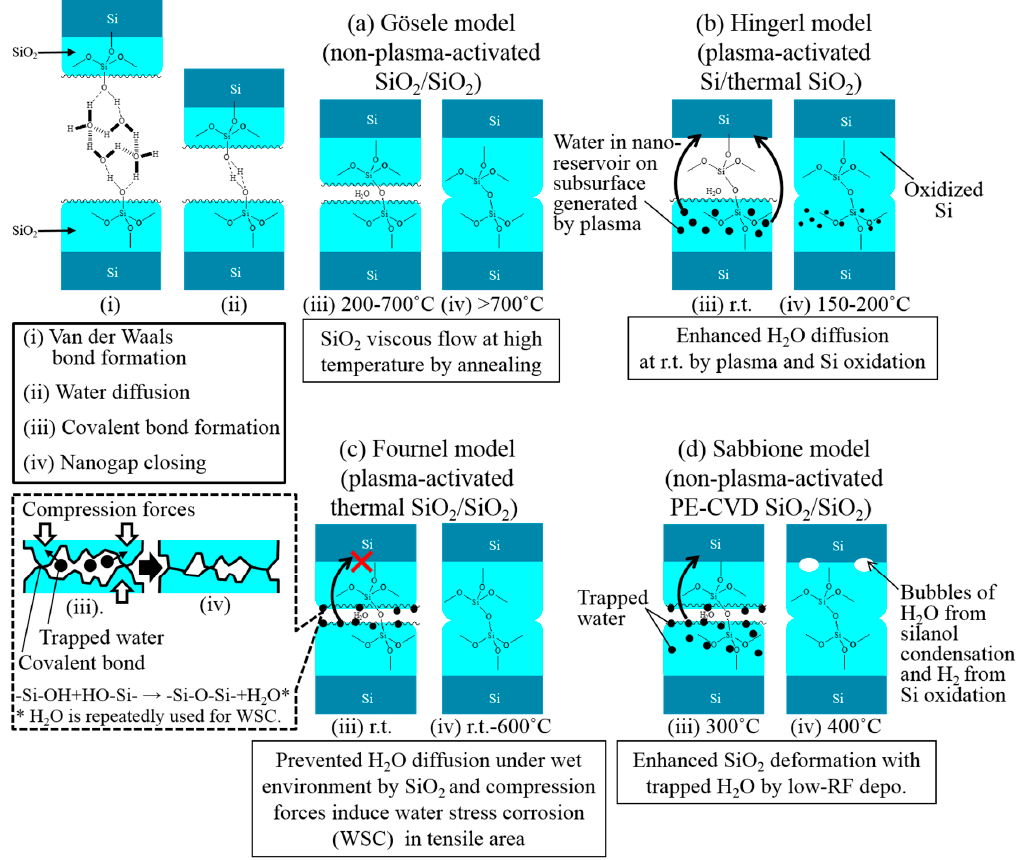
Figure 9. Four models of Si/SiO 2 and SiO 2 /SiO 2 direct wafer bonding.